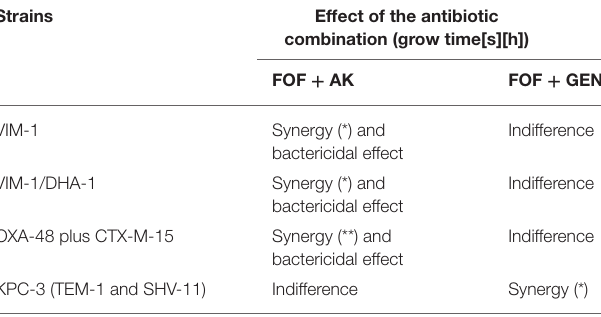
TABLE 2 | Time-kill curves for fosfomycin (FOF) plus amikacin (AMK) and fosfomycin (FOF) plus gentamicin (GEN) against four clinical strains of carbapenemase producing strains.